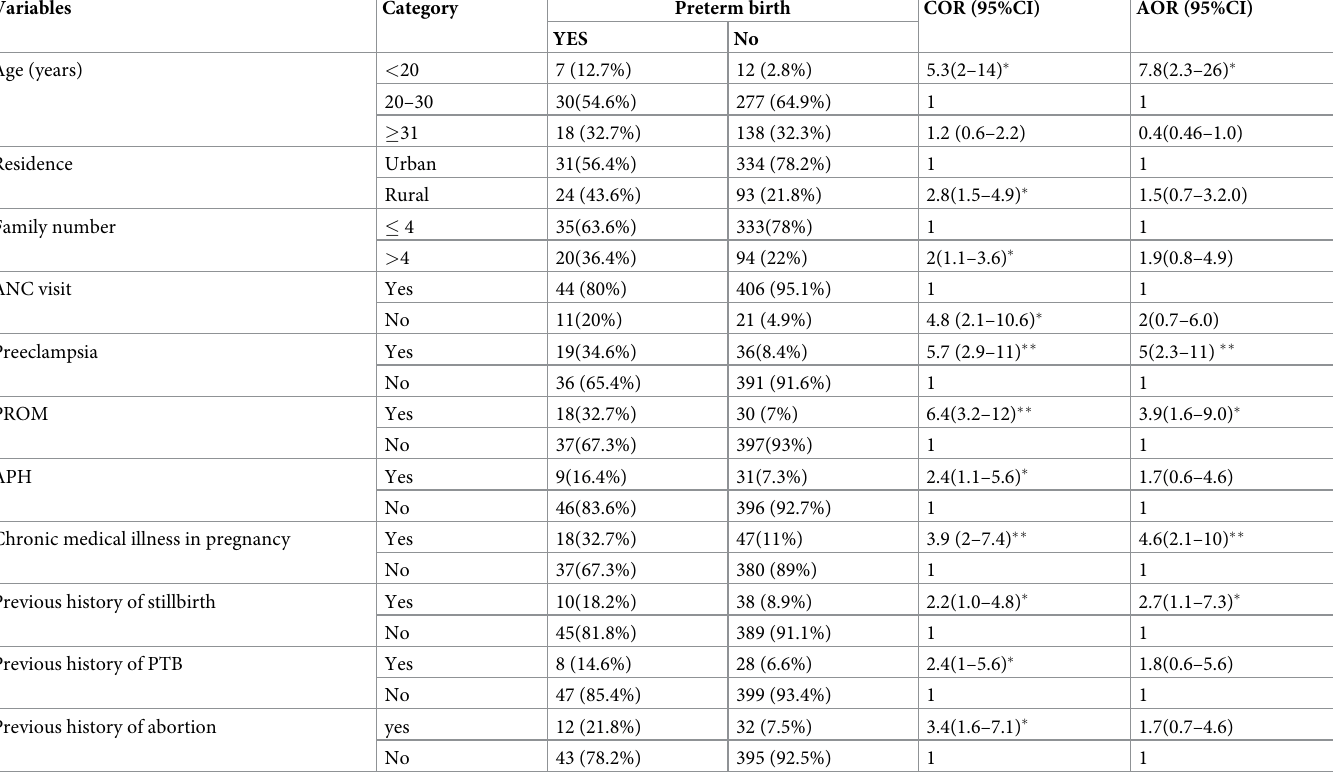
Table 3. Factors associated with PTB among (n = 482) newborns delivered in governmental referral hospital, Amhara Region, Northwest Ethiopia